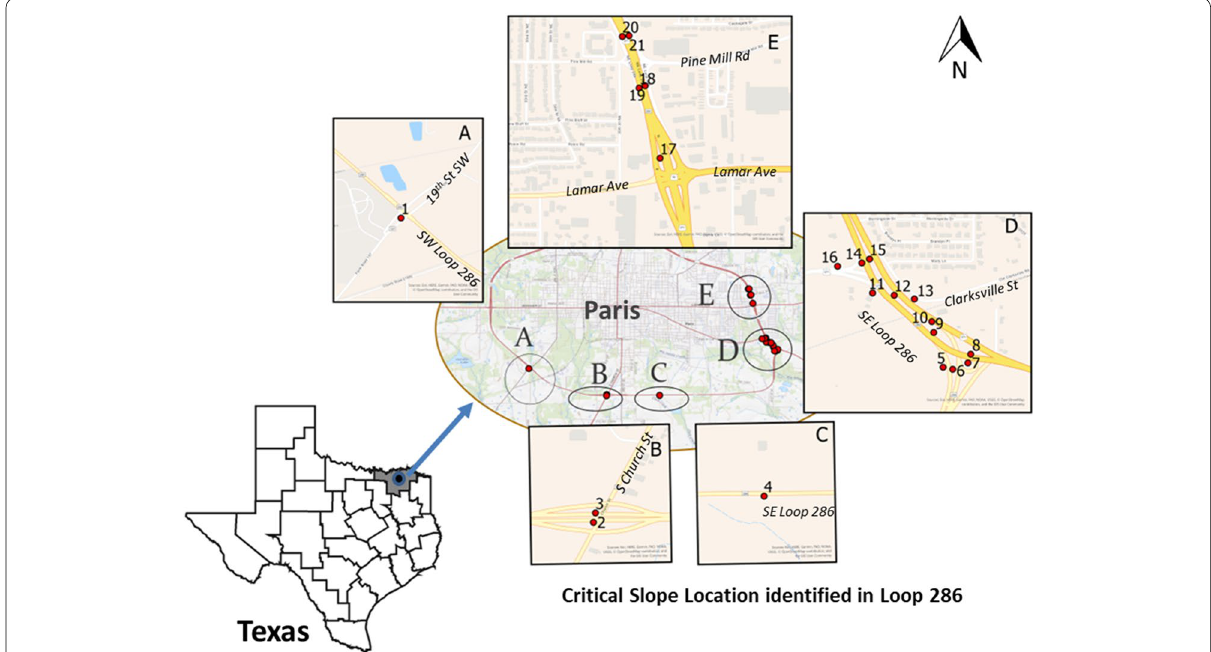
Fig. 6 Slopes with high failure susceptibility in Loop 286 of Paris district,